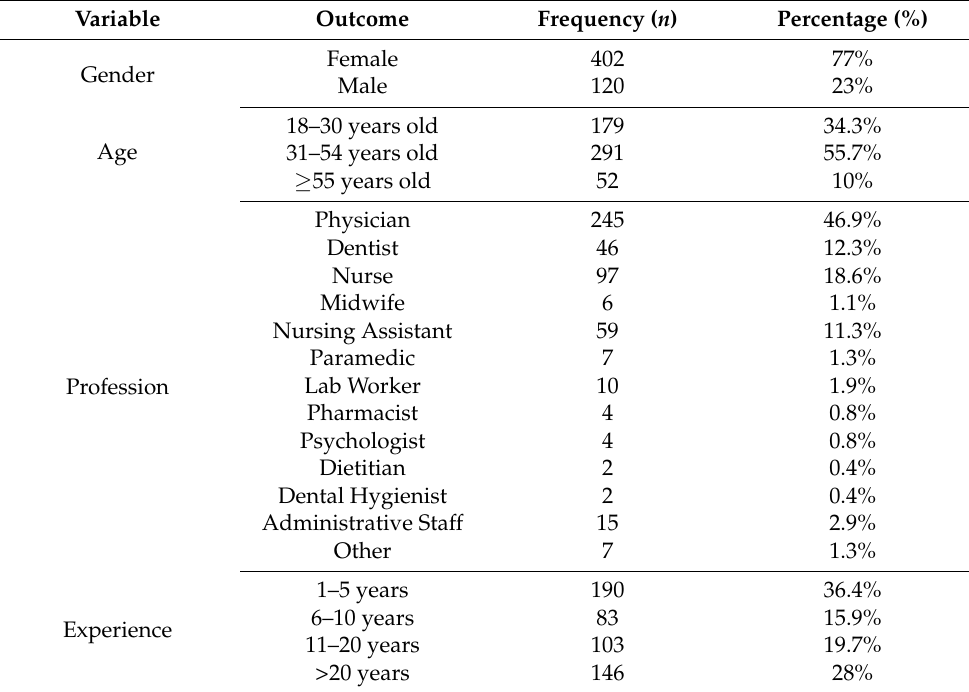
Table 1. Demographic characteristics of Slovak healthcare workers who received BNT162b2, February–March 2021 ( n =